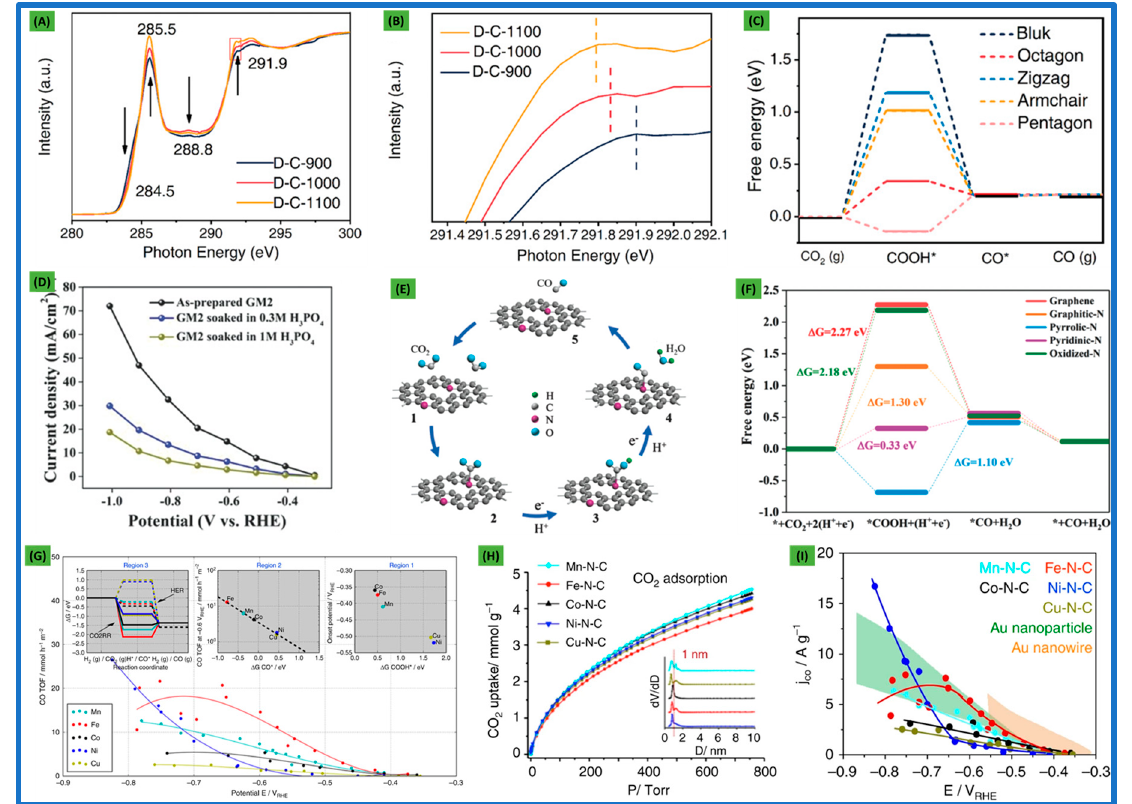
Figure 10. C K-edge NEXAFS spectra ( A ), expanded view of NEXAFS spectra ( B ), and DFT calculations for ECR activities of variously defective D-NC–X electrocatalysts ( C ) [238]. Multipotential curves of GM2 electrocatalyst ( D ), illustration of the CRR processes ( E ), and free energy diagram ( F ) of various N–GRW electrocatalysts [239]. The catalytic reactivity trends ( G ), CO 2 physisorption isotherm with inset of the pore size distribution ( H ), and catalyst mass-normalized CO partial currents vs. applied potential ( I ) of distinct M-N-C electrocatalysts [240].